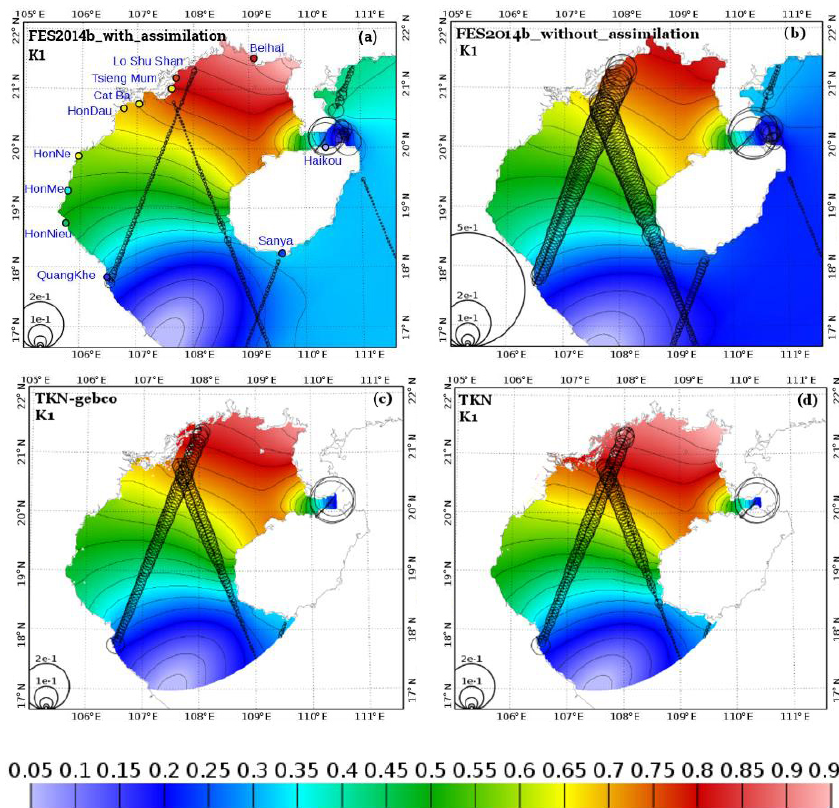
Figure 6. Same as Fig. 5 for K 1